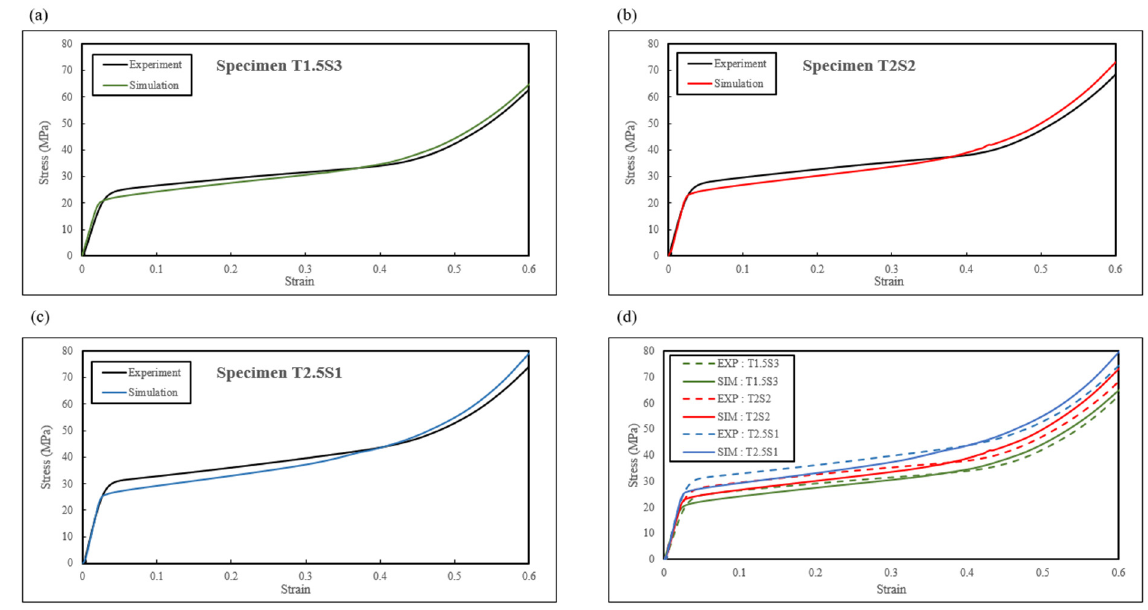
Figure 12. Comparison of experimental and simulated stress–strain curves of ( a ) specimen T1.5S3, ( b ) specimen T2S2, and ( c ) specimen T2.5S1. ( d ) Comparison of the stiffness of all three specimens.